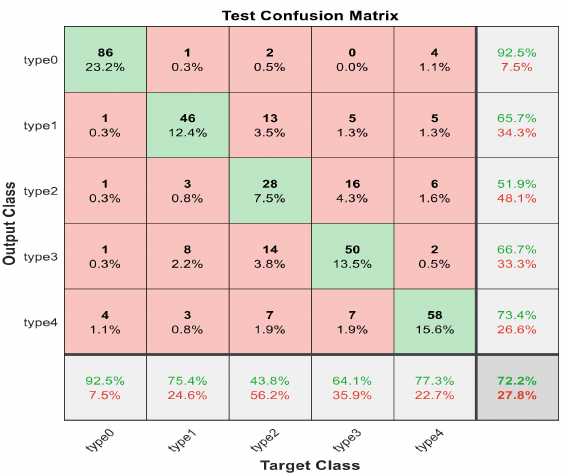
Figure 21. The confusion matrix with for type grading using 1000 deep learning